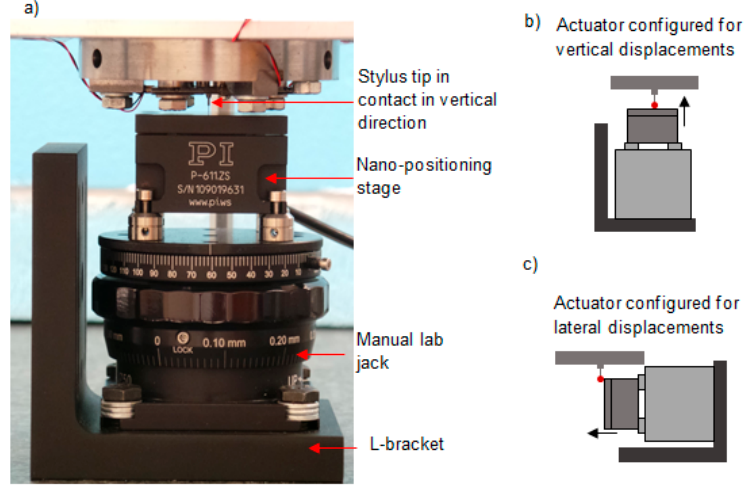
Figure 7. ( a ) An image of the experimental setup used for testing the micro-probe in the vertical direction; ( b ) actuator configured for vertical displacements; ( c ) actuator configured for